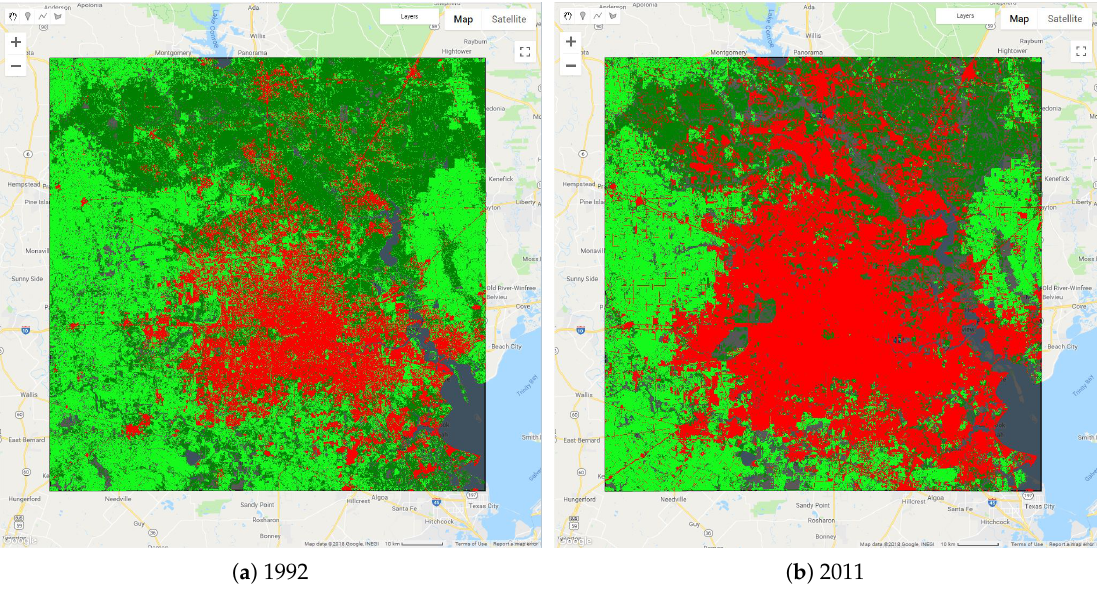
Figure 16. Houston MA: LC situation in 1992 ( a ) and in 2011 ( b ). In red, the Urbanized class, in light green, the Cultivated class, in dark green, the Forest class.